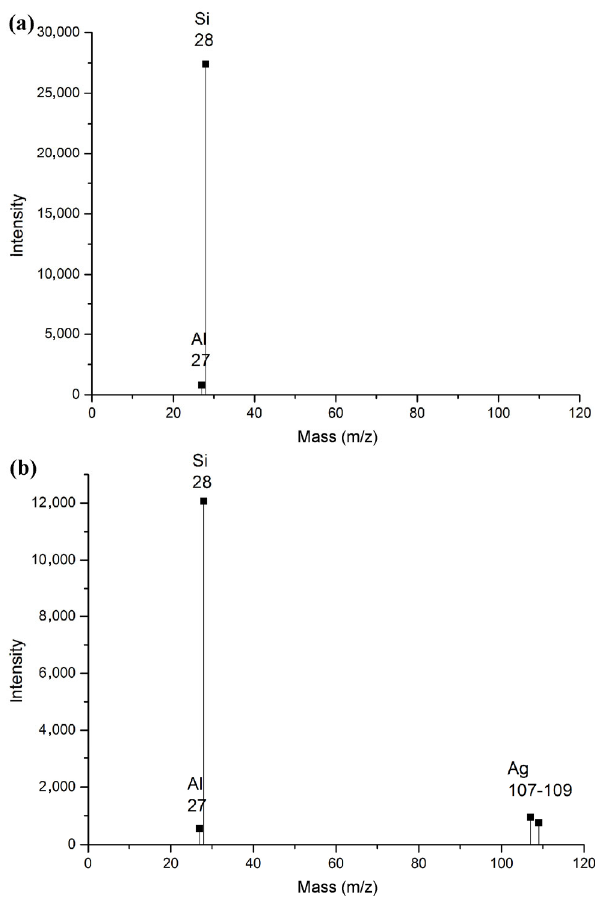
Fig. 3 TOF-SIMS spectrum of the colloidal silica abrasive (a) and Ag-doped colloidal silica abrasive containing 1.5 wt% Ag 2 O (b).